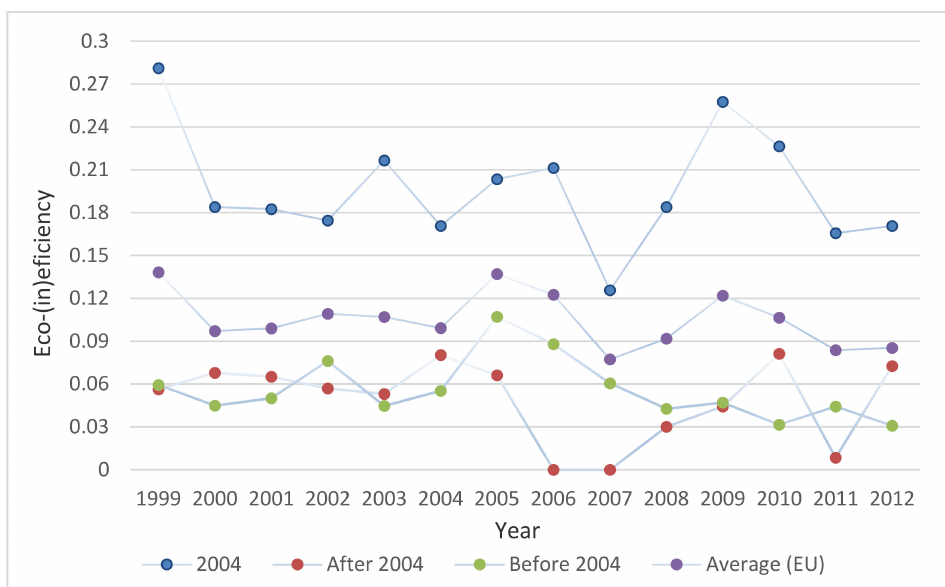
Figure 1. Average Eco-(in)efficiency of EU agricultural sector and average Eco-(in)efficiency by groups of countries according to their date of accession (1999–2012) (Source: Own